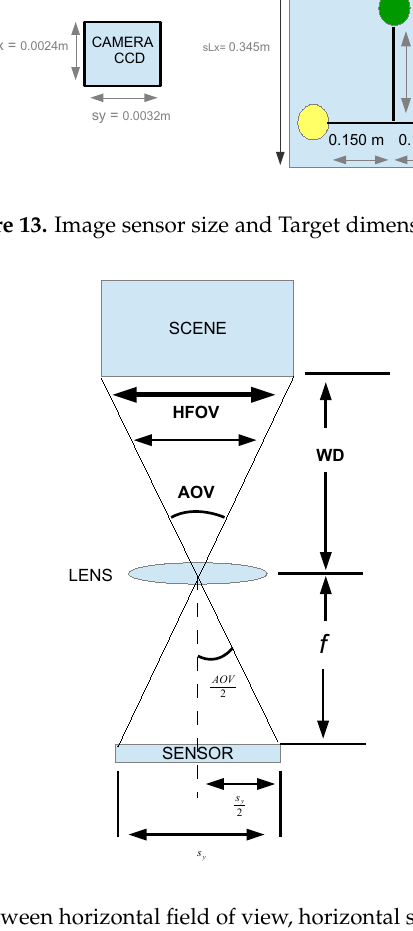
Figure 14. Relationship between horizontal field of view, horizontal sensor size and working distance for a given angle of